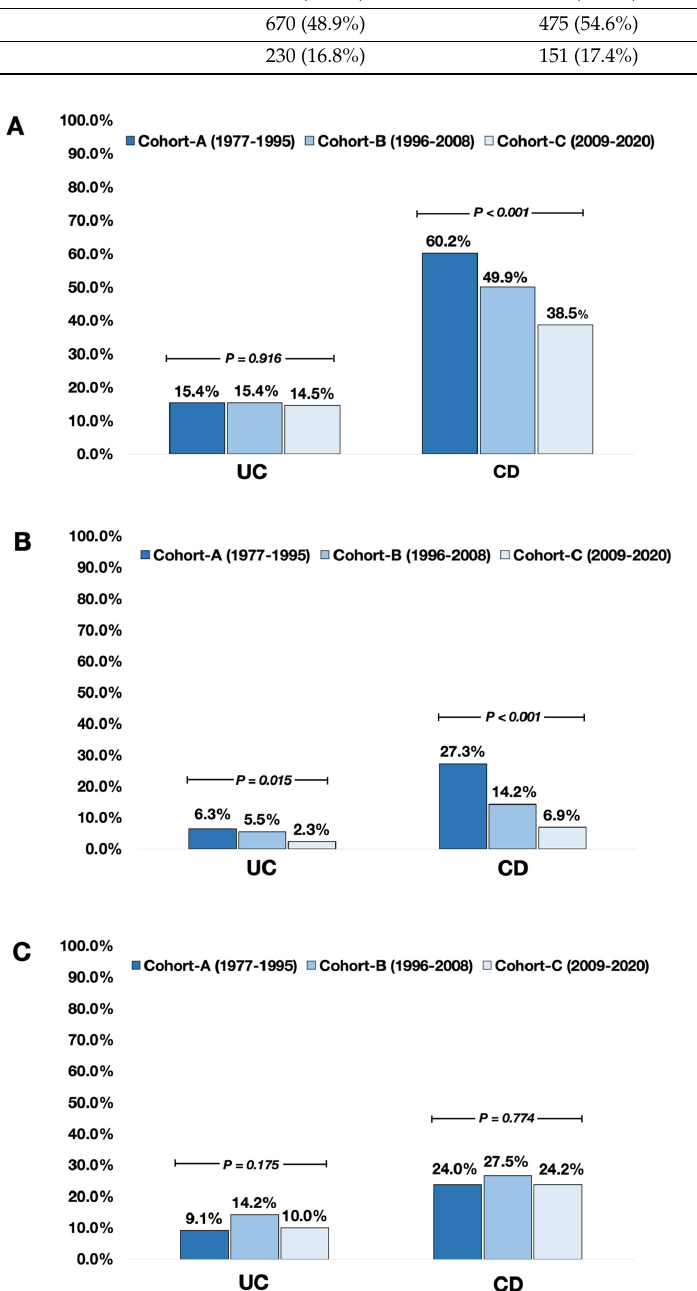
Figure 1. The trend of environmental and socioeconomic risk factors in the incident UC and CD patients. Note: ( A ) active smoking at diagnosis, ( B ) appendectomy before diagnosis, ( C ) oral contraceptive use at diagnosis.